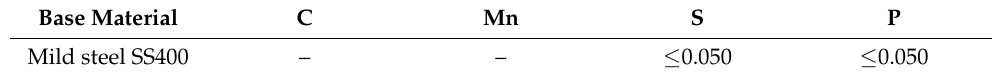
Table 1. Chemical compositions (mass%) of base material plates (JIS G 3101-2015).